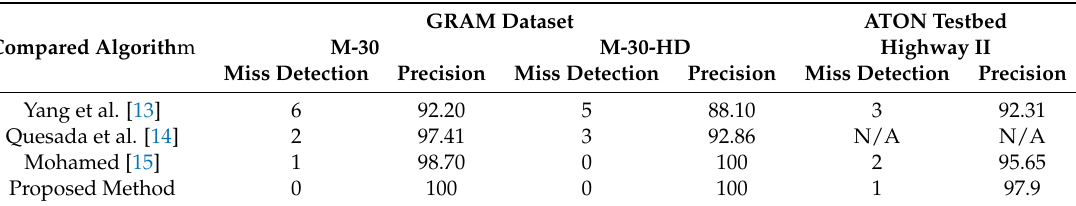
Table 4. Vehicle counting accuracy for first